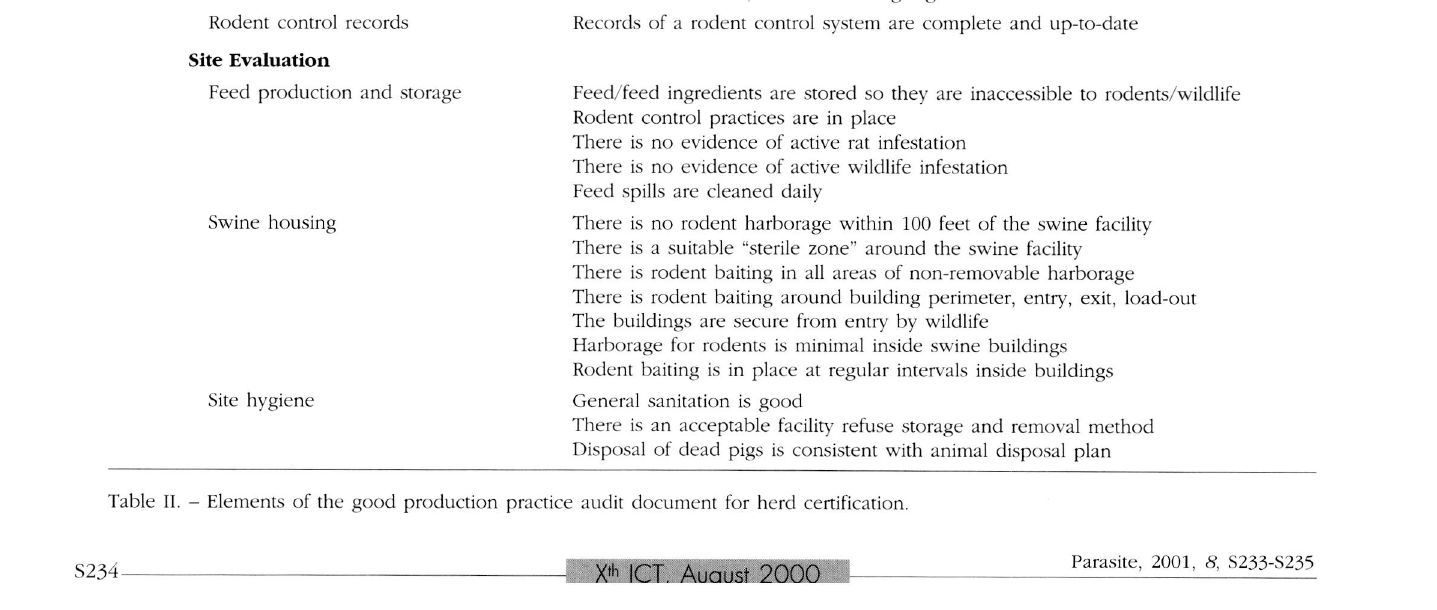
Table II. - Elements of the good production practice audit document for herd